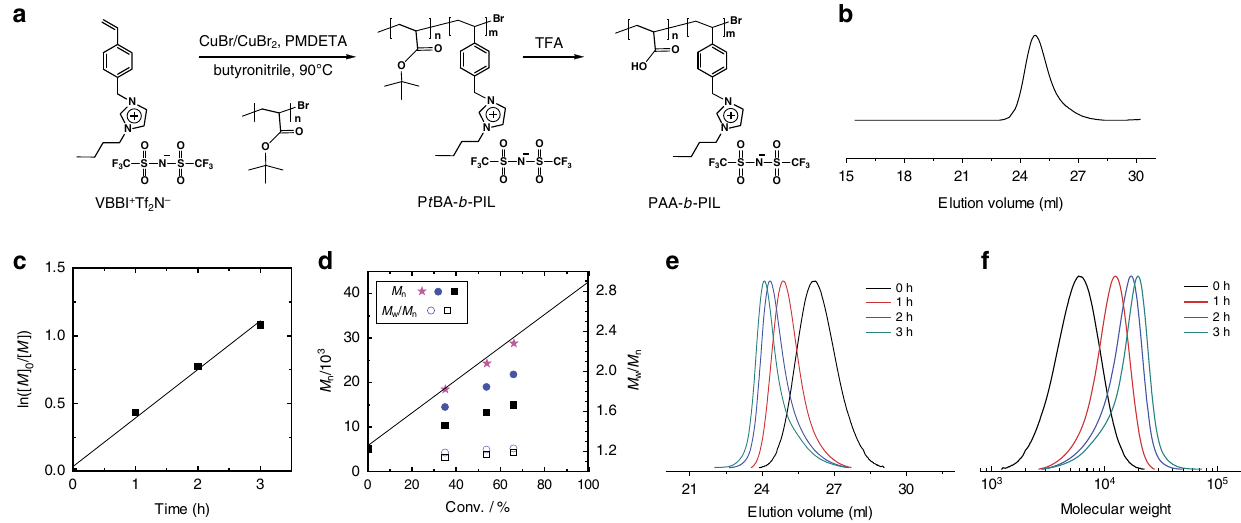
Figure 1 | Block copolymer synthesis and characterization. ( a ) Synthetic approach to PAA- b -PIL through ATRP using P t BA-Br as the macroinitiator. ( b ) GPC elution of P t BA 45 - b -PIL 23 in THF containing 10 mM LiTf 2 N and 10 mM 1-butylimidazole. ( c ) Plot of ln([ M ] 0 /[ M ]) versus time. ( d ) Plot of M n and M w / M n versus conversion. M n was accessed by NMR (pink stars). M w was obtained from GPC analysis using linear polystyrene (black squares) and polyVBBI þ Tf 2 N (cid:2) RAFT standards (blue circles). Samples were taken at different times from the polymerization. ( e , f ) GPC traces of polyVBBI þ Tf 2 N (cid:2) (in THF containing 10mM LiTf 2 N and 10mM 1-butylimidazole) calibrated using linear polystyrene standards. Conditions: [VBBI þ Tf 2 N (cid:2) ] 0 /[P t